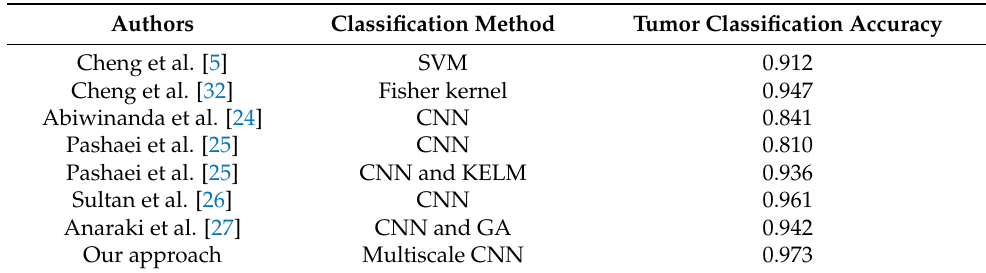
Table 4. Comparison of the proposed approach with other approaches over the same T1-CE MRI image